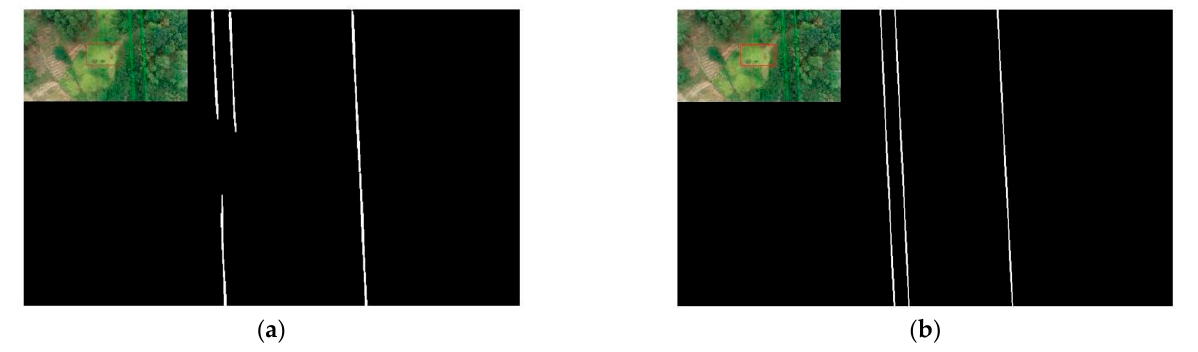
Figure 12. Comparison of two methods for solving the power line breakage problem. ( a ) Mask RCNN; ( b ) Mask RCNN + CDGFA.